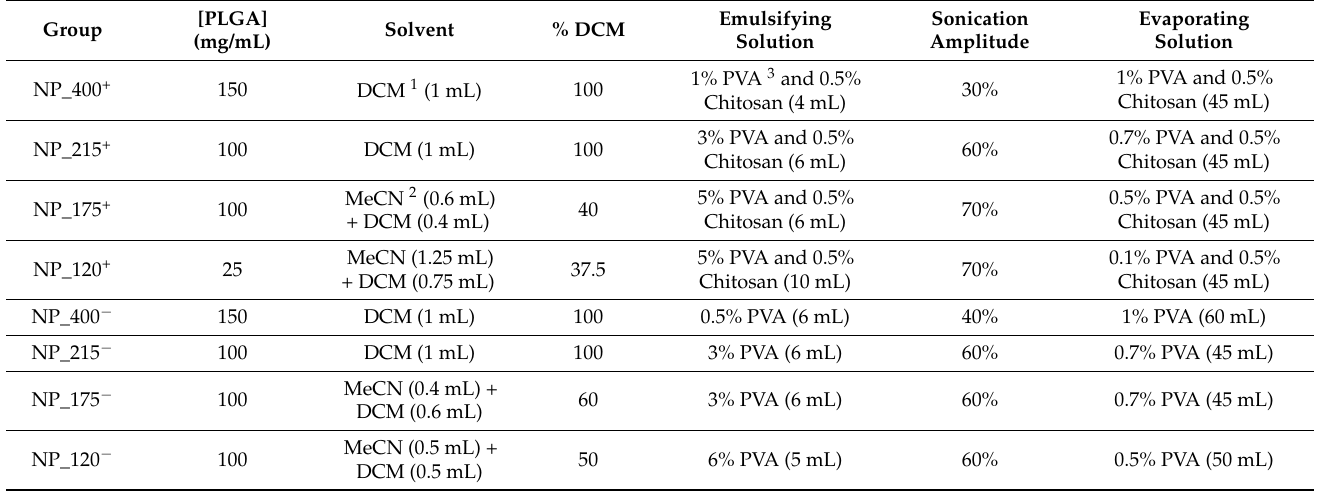
Table 1. Nanoparticle Synthesis